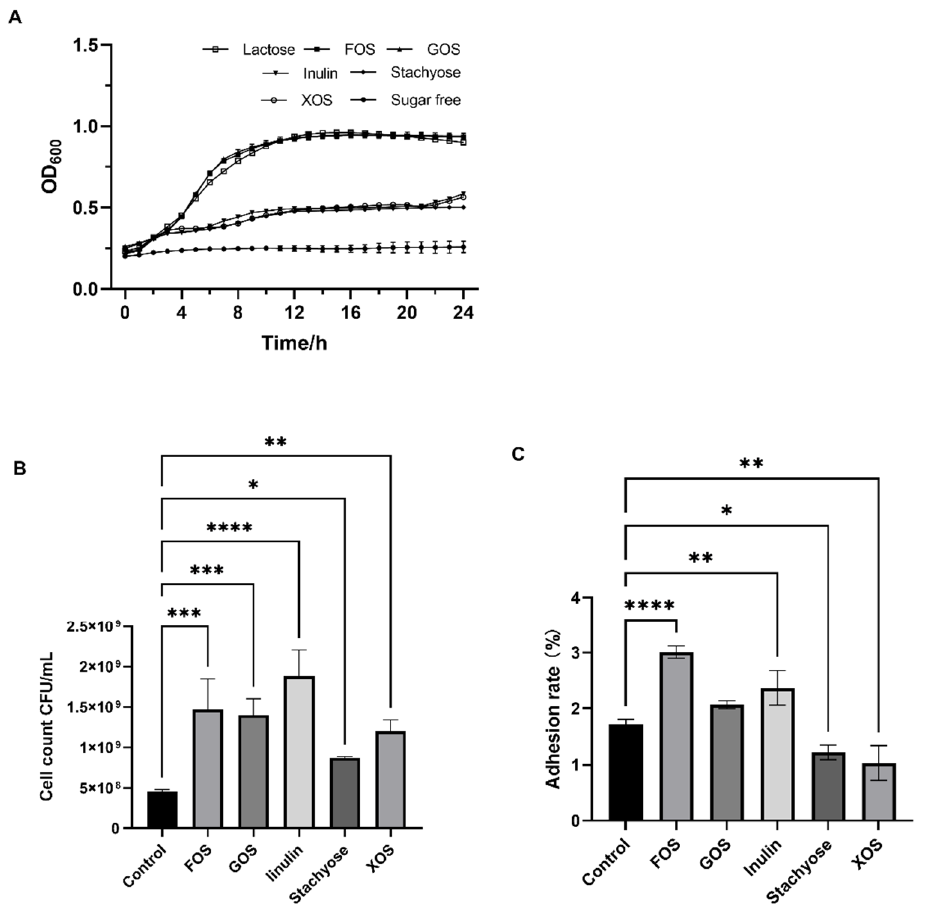
Figure 1. Effects of probiotics on growth, number of living bacteria, and adhesion rate of L. fermentum DALI02. ( A ) Effects on growth condition; ( B ) Effects on living bacteria; and ( C ) Effects on adhesion rate. * indicates a significant difference between groups ( p < 0.05), ** indicates a significant difference between groups ( p < 0.01), *** indicates a significant difference between groups ( p < 0.001), **** indicates a significant difference between groups ( p < 0.0001).